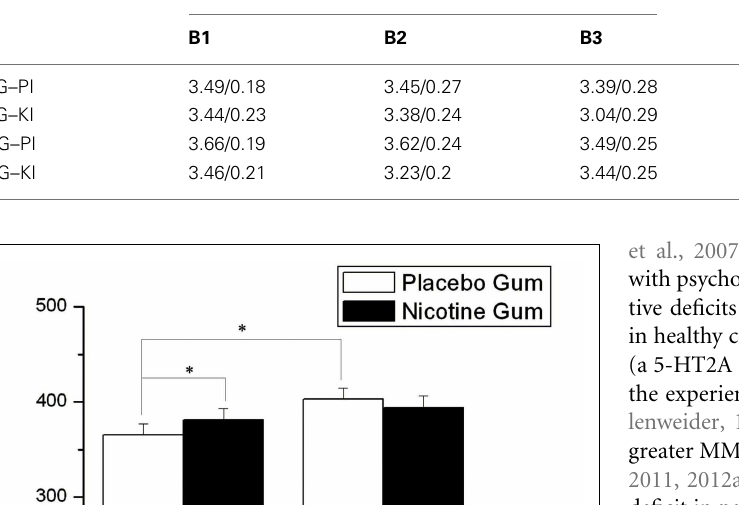
Table 1 | Mean/ ± SE d (cid:48) scores of L-HD and H-HD groups across treatment conditions and time blocks (B1–B3). Treatment